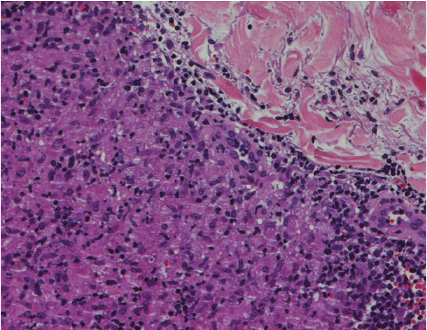
Figure 3: H&E staining, 200x magnification. Sarcoidosis-like gran- ulomas are composed by epithelioid macrophages aggregates, sur- rounded by a scarce rime of small lymphocytes. Neither asteroid bodies nor Schaumann bodies were observed.